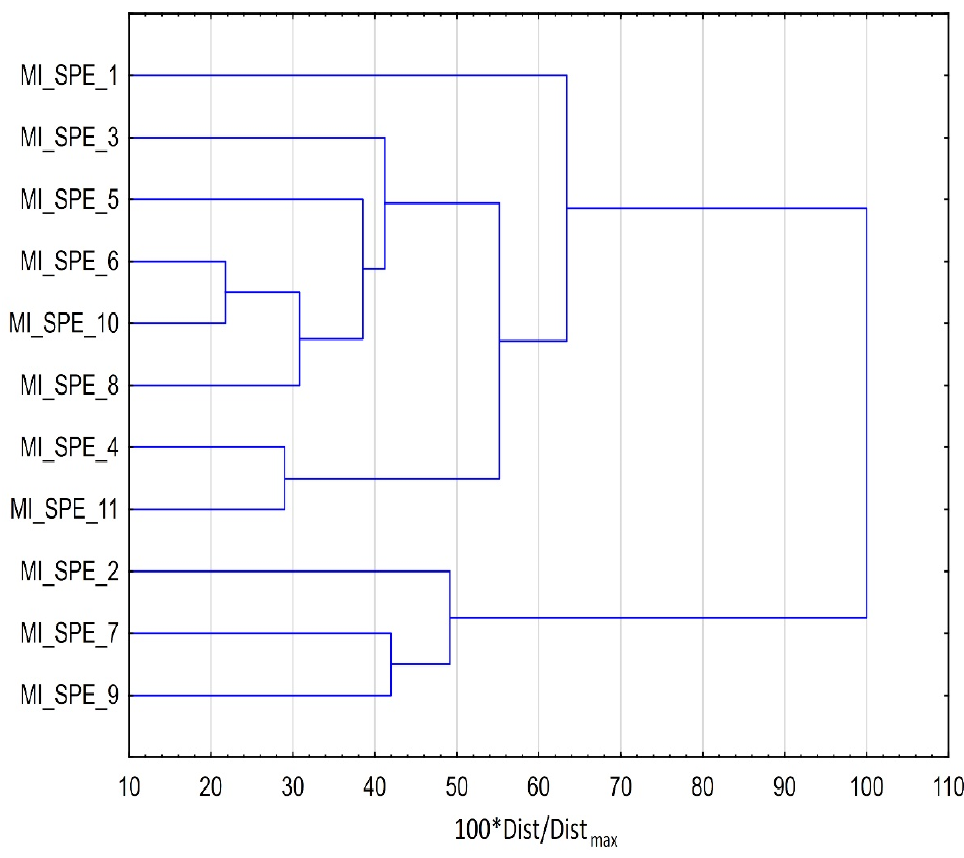
Figure 3. Grouping of procedures based on MI-SPE, obtained with cluster analysis.